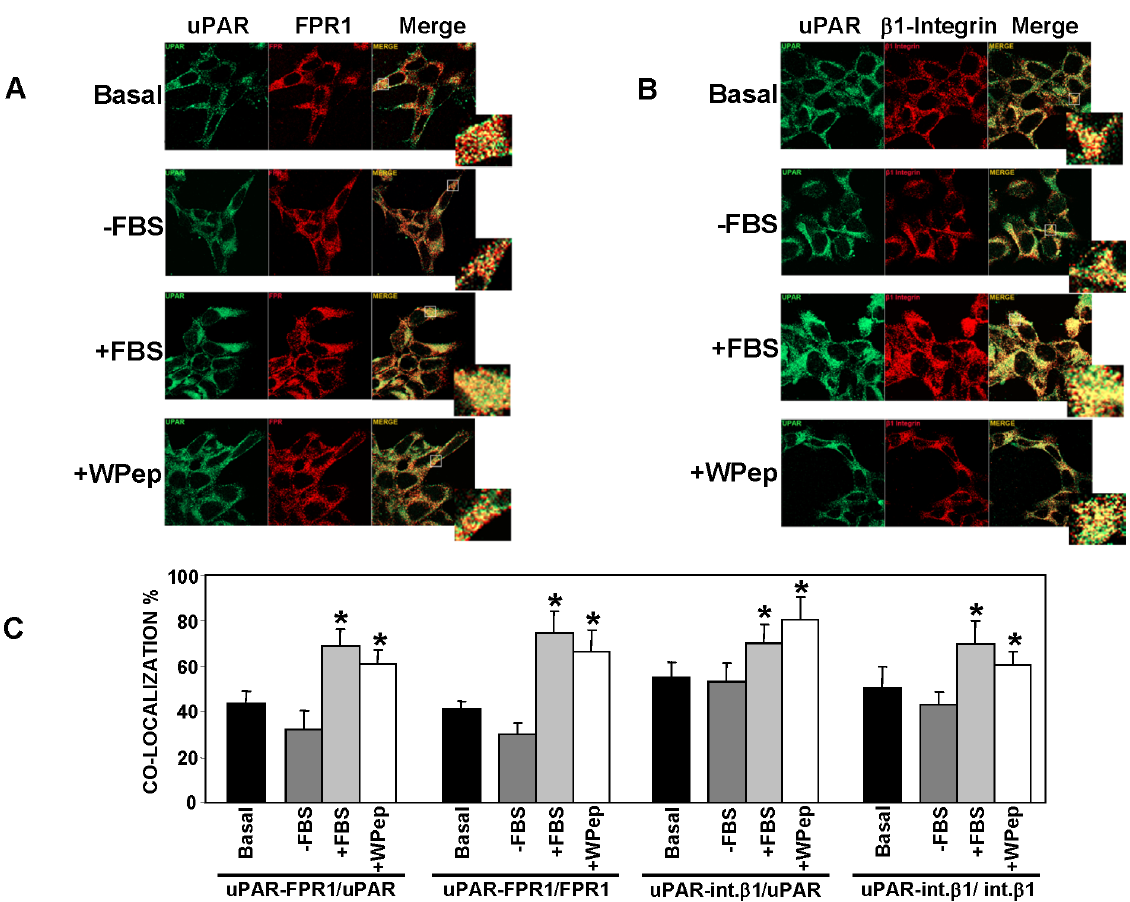
Figure 1. FPR1 co-localizes with uPAR on the surface of uPAR-expressing HEK-293 cells. HEK-293 cells stably transfected with uPAR cDNA (uPAR-293 cells) were seeded on glass coverslips and transiently transfected with FPR1 cDNA. After 24 h, cells were incubated for further 24 h in culture medium (DMEM) containing 10% serum (Basal) or in DMEM without serum ( 2 FBS). Prior to fixation, some serum-starved samples were stimulated for 1 h at 37 u C, 5% CO2, with 10% FBS in DMEM ( + FBS) or with 5 nM WKYMVm peptide ( + W Pep). All samples were then fixed, incubated with the anti-uPAR monoclonal R4 antibody and the anti-FPR1 polyclonal antibody ( A ) or with the anti-uPAR monoclonal R4 antibody and the rabbit anti- b 1 polyclonal antibody ( B ), stained with Cy3 or Alexa 488 conjugated secondary antibodies, and analyzed by confocal microscopy. The insets show a 4 6 magnification for the indicated region in each merge image. C: The degree of co-localization of the fluorescent signals was quantified on a minimum of 50 different cells by using the LSM 510 software. The number of co-localizing pixels was normalized to the total pixels of each fluorophore. Thus, the number of yellow pixels, corresponding to co-localizing uPAR-FPR1, has been normalized to green (uPAR) or red (FPR1) pixels shown in A and reported in 1 st and 2 nd set of columns, respectively. The number of pixels corresponding to co-localizing uPAR- b 1 integrin has been normalized to green (uPAR) or red ( b 1 Integrin) pixels shown in B and reported in 3 rd and 4 th set of columns, respectively. (*) p # 0.05, as determined by the Student’s t test. 22.5 m l of LipofectAMINE 2000 (Invitrogen) in serum-free DMEM for 5 h at 37 u C (5% CO2). Cells where then lysed after